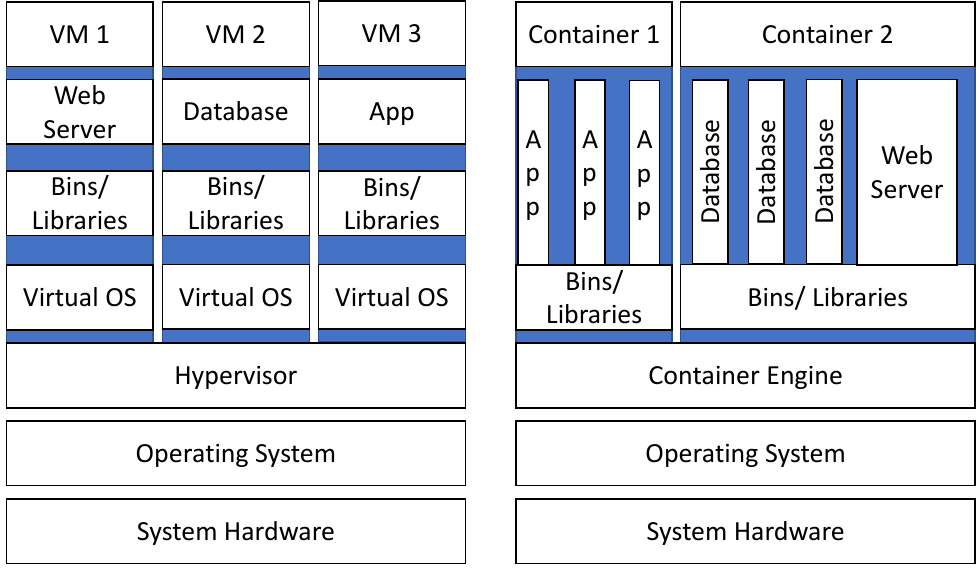
Figure 5. Virtualization versus